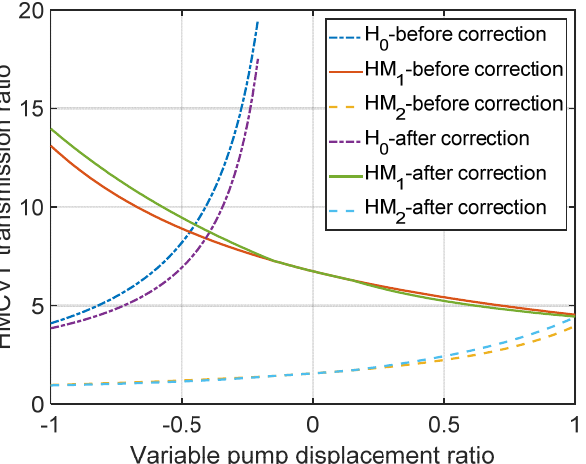
Figure 13. The comparison of speed regulating characteristics before and after correction. According to Figure 13, 2 R , the coefficient of determination, of the speed regulating